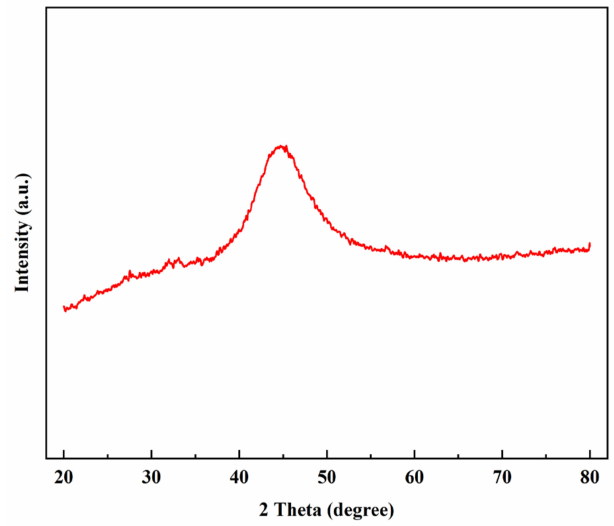
Figure 5. XRD pattern of Ni-P coating.